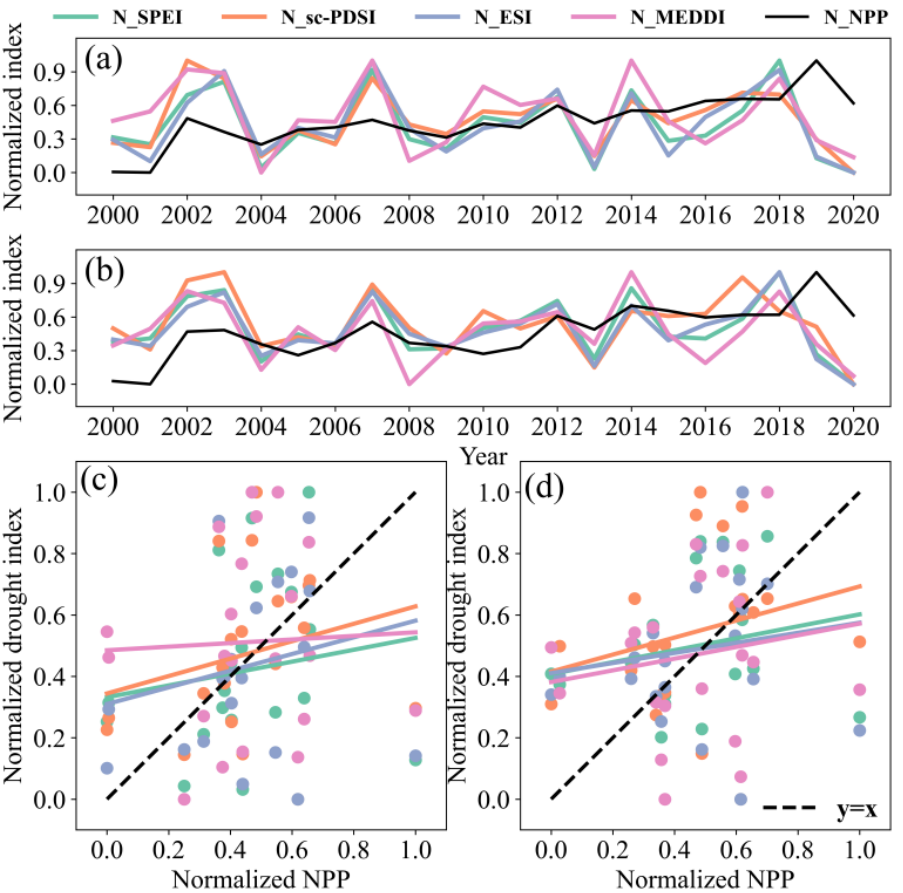
Figure 3. Temporal variation in meteorological drought index and NPP during the growing season from 2000 to 2020: ( a ) grassland and forest area and, ( b ) farmland area. The scatter plot distribution of meteorological drought index and NPP: ( c ) grassland and forest area, ( d ) farmland area.